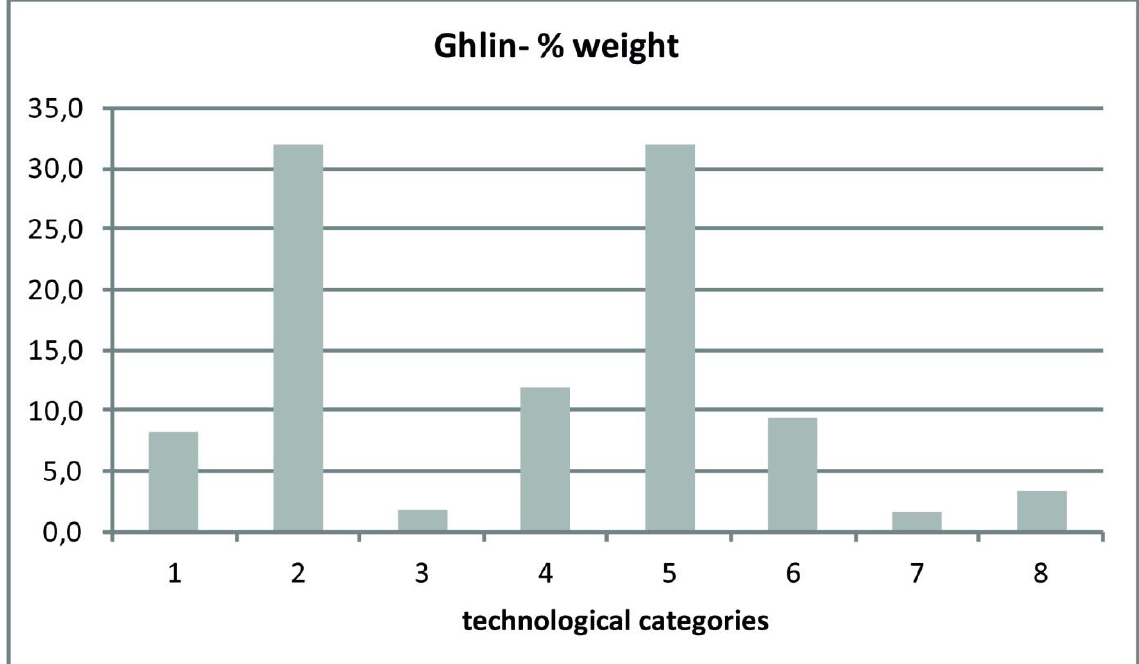
Figure 7. Techno-economical diagram of the laminar production in Ghlin flint (in weight, g). 1. big flakes of the beginning of the shaping out, 2. flakes coming from the preparation of the crests, 3. crests, 4. maintenance flakes of the debitage, 5. blades, 6. flakes attributed to the blades production but which can’t be precisely replaced in the chaîne opératoire, 7. very little flakes that those produced by retouches and the tools spall, 8. final waste of the production which are the cores and the flakes from the recovery of the cores. Based on 1221 pieces (4823